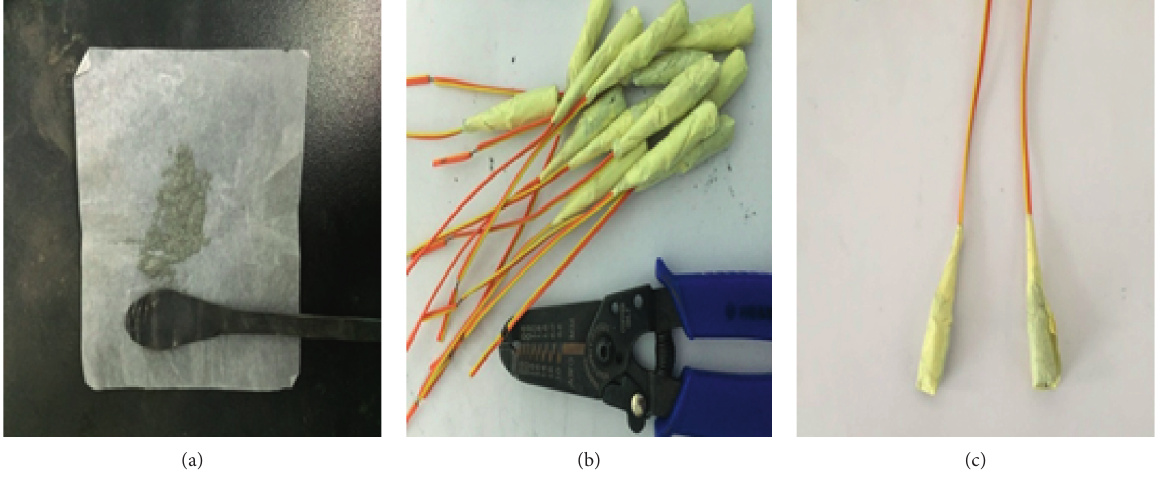
Figure 6: Fabrication of ignition heads: (a) powder charge; (b) shear cut; (c) end product. Table 3: Characteristics of ignition head explosion with different